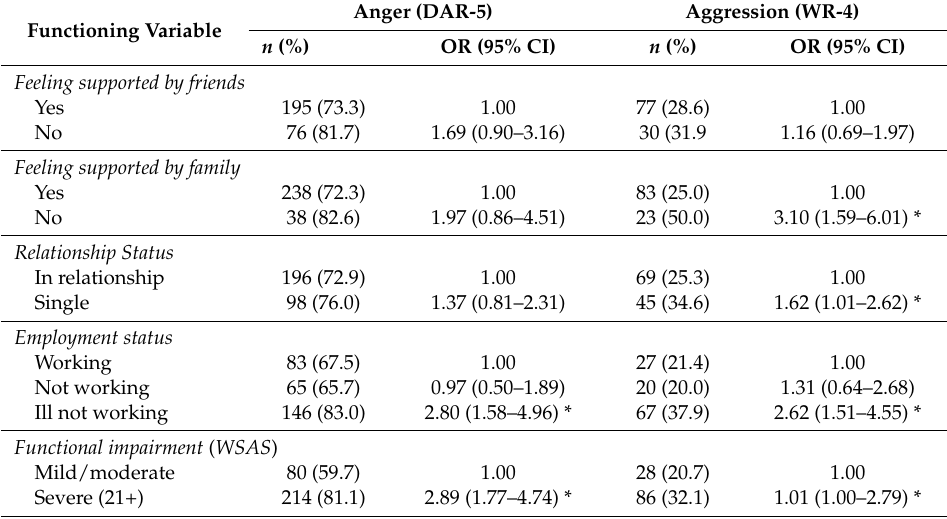
Table 2. Associations between factors related to functioning and anger and